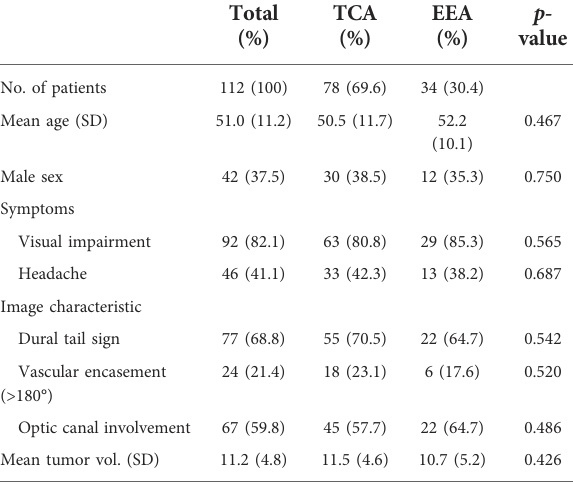
TABLE 1 Main clinical manifestations of all